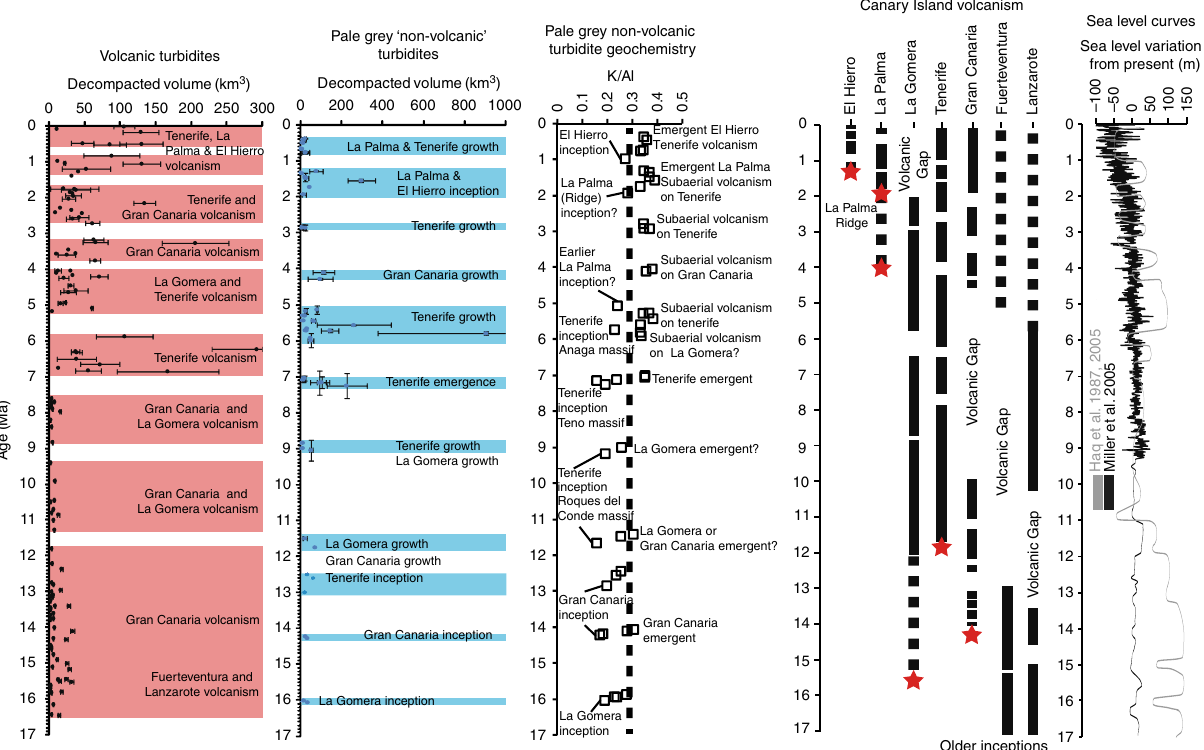
Fig. 6 Summary diagram. Figure shows the timing and decompacted volume of pale-grey ‘ non-volcanic ’ turbidites (blue shaded clusters) and grey volcaniclastic turbidites (red shaded clusters). These are plotted against the temporal distribution of volcanic activity of the Canary Islands and sea level curves. Red stars indicate subaerial emergence of the islands based on terrestrial dates from basal complexes 27 – 30,71 –